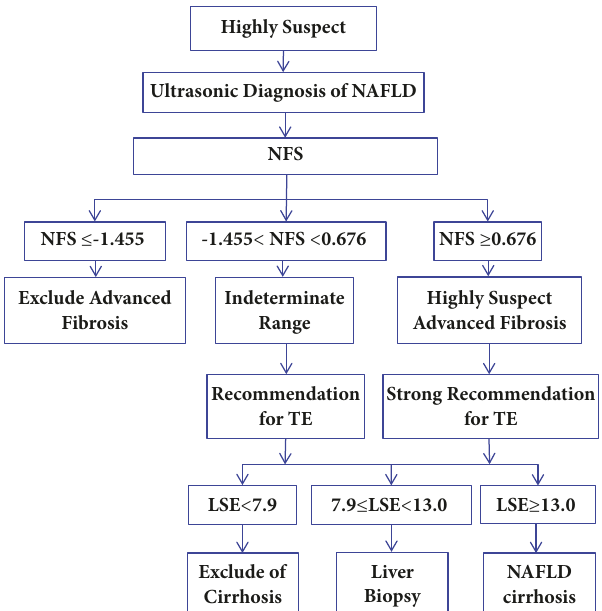
Figure 1: Proposal of diagnostic algorithm for classification of patients affected by NAFLD. NAFLD: nonalcoholic fatty liver disease;NFS:NAFLDfibrosisscore;TE:transientelastography;LSE: liver stiffness measurement; kPa: